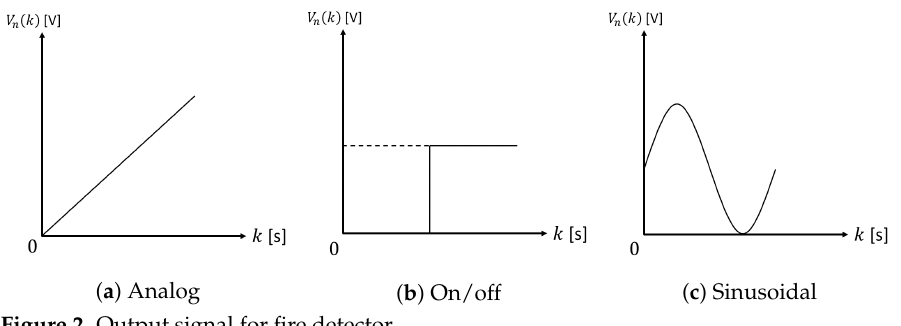
Figure 2. Output signal for fire